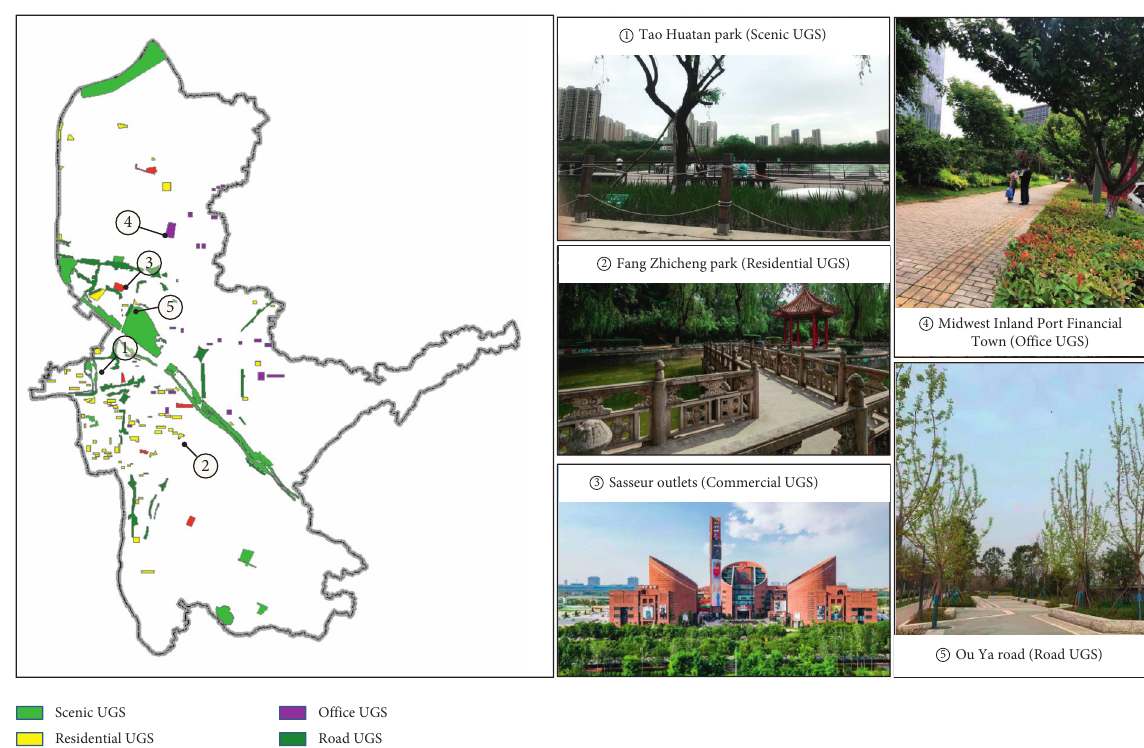
Figure 4: Spatial distribution of major UGSs in Baqiao District as well as the locations and images of the selected study